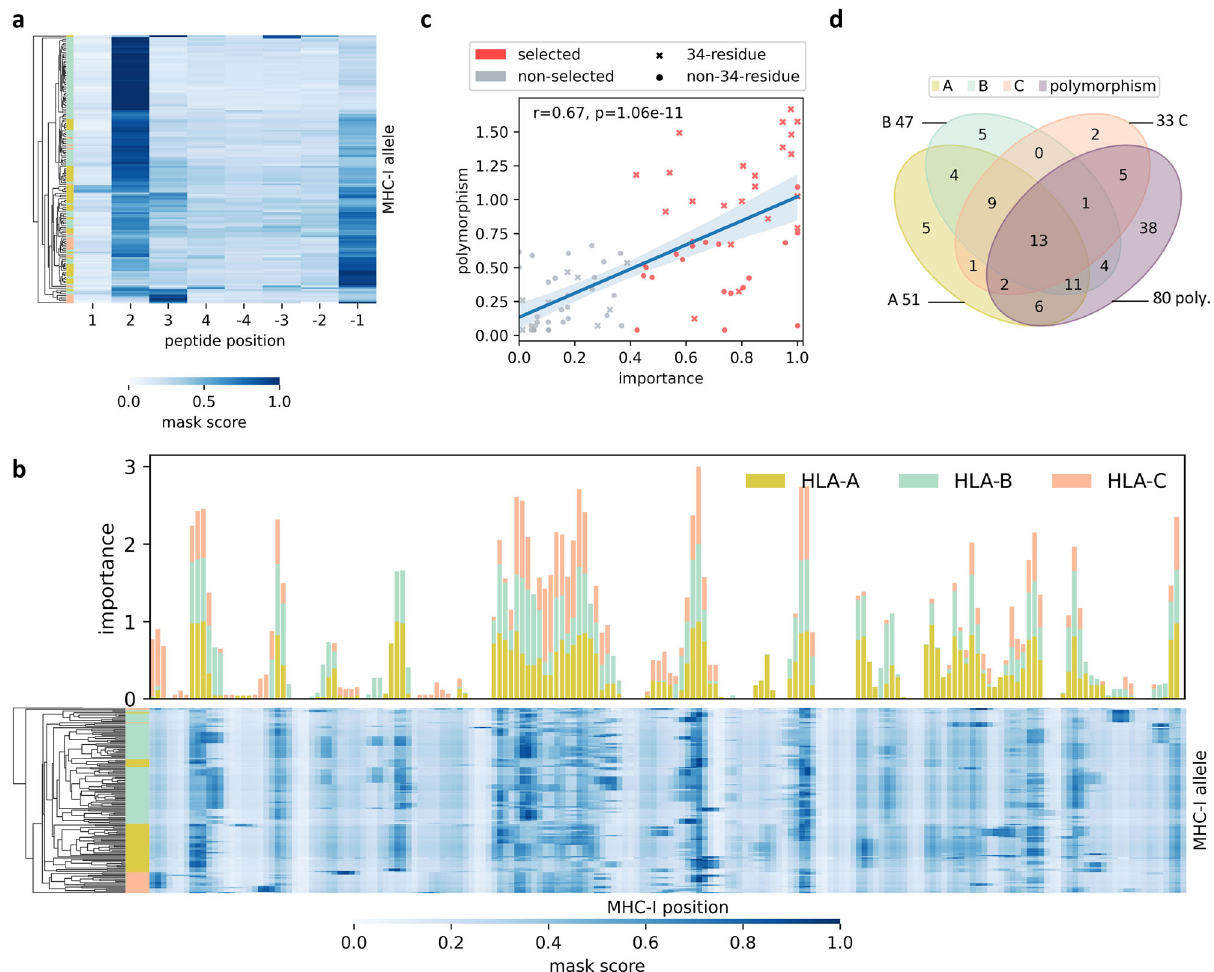
Fig. 3 Selection of the important positions. a A clustering heatmap of the peptide mask on each peptide position of each allele. b A stack plot of the position importance of HLA genes at each MHC-I residue and a heatmap of allele masks derived from ScoreCAM results with clustering on alleles. These two plots are aligned by MHC-I-binding cleft sequences, to better demonstrate the distribution of mask scores. In the stack plot, different HLA genes were counted independently due to the number of alleles with variation as well as the divergent patterns of conserved or polymorphic sequences (Supplementary Fig. 4). As for the heatmap clustering in a , b , we used Euclidean distance and unweighted average linkage for clustering mask scores, and the row color is used to label the HLA gene. c A scatterplot with linear correlation shows the relationship between polymorphism and importance of each polymorphic MHC- I residue ( n = 80). Information entropy ( − Σ P × ln( P ), where P is the amino acid frequency) is used to represent the degree of polymorphism. The important positions selected using ScoreCAM are colored in red, and the 34 residues derived from NetMHCpan4.1 are cross-marked. The blue band represents the 95% con fi dence interval of the regression fi t, and the line represents the estimated regression. d A Venn diagram shows the intersection of the important position set from each HLA gene and the polymorphic residue sets. Residues in the set of “ ( A ∪ B ∪ C ) ∩ polymorphism ” are selected as the 42 important positions of MHCfovea. Source data are provided in Supplementary Data 5 and